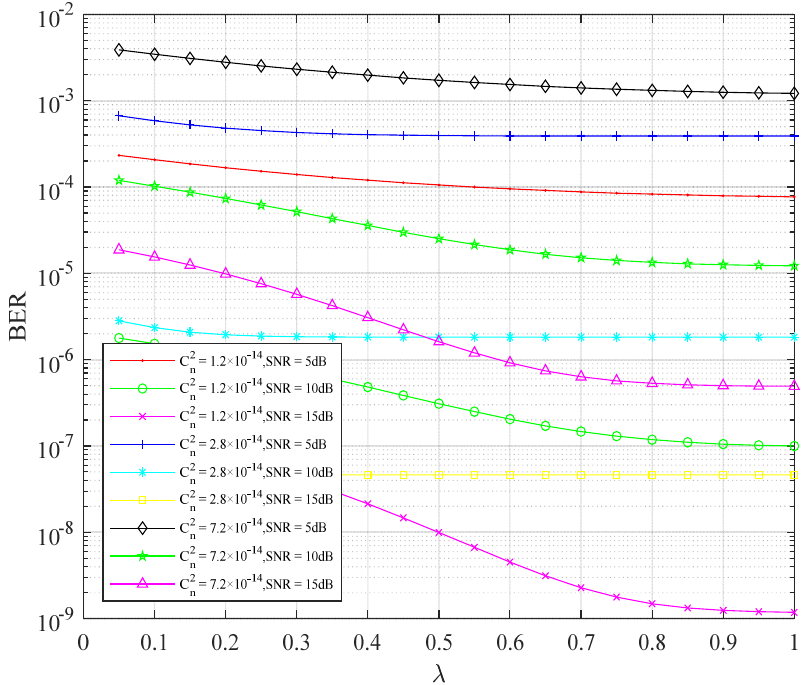
Figure 4. Comparison of system BER performance under different constellation priority parameters.